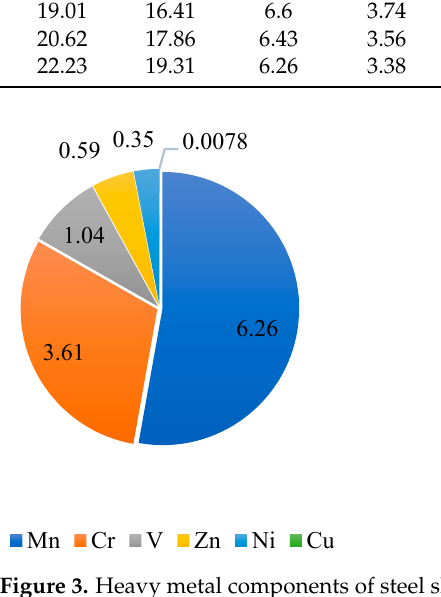
Figure 3. Heavy metal components of steel slag.